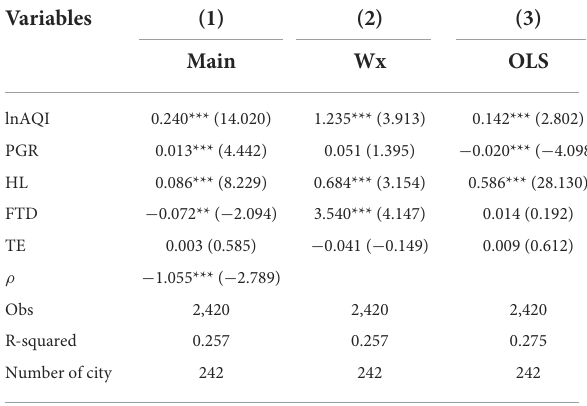
TABLE 3 SDM model regression estimation results.